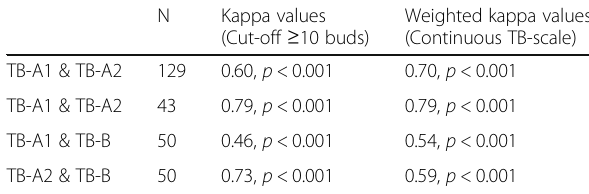
Table 3 Intra-and inter-observer kappa values for semi- Table 5 Intra- and inter-observer agreement data for scoring of quantitative estimates of tumour stroma ratio tumour budding N Kappa values Kappa values Weighted kappa N Kappa values (TSR: 4-groups) (TSR: High/Low) (TSR: 4 groups) (Cut-off ≥ 10